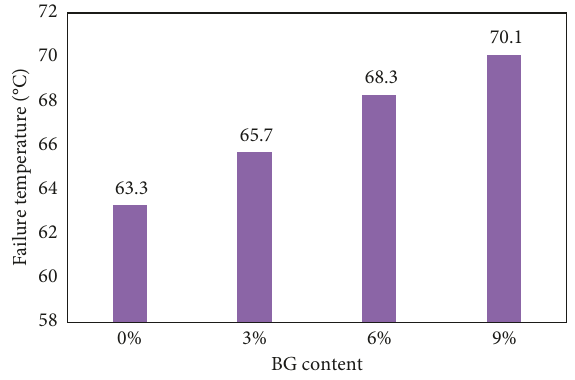
Figure 10: Influence of BG on performance grade